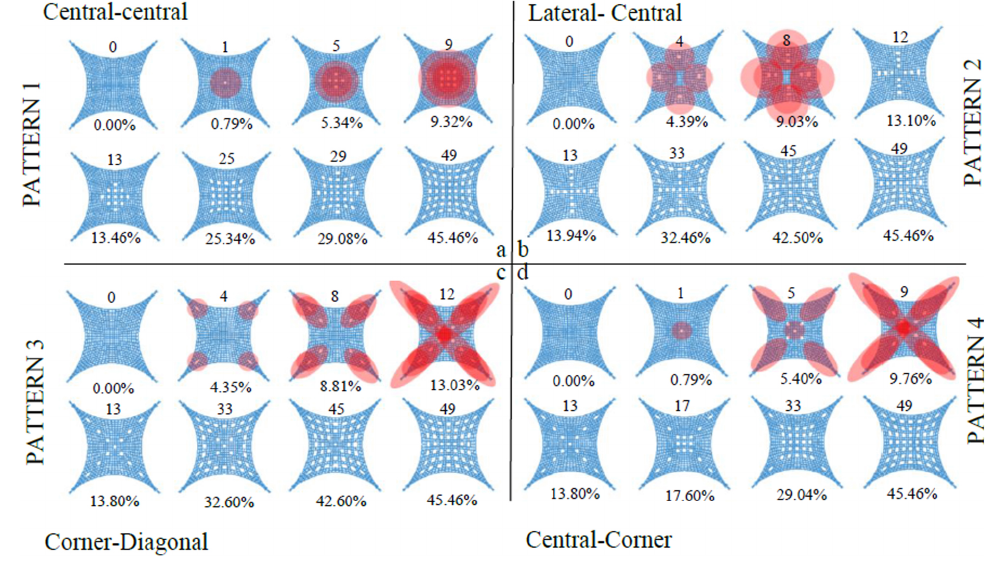
Figure 3: The different patterns were divided into 4 families according to four different strategies of the positioning of the holes. Different paths for the increasing growth of the pierced areas on the vaults are used (red shaded indicators represented the four beginning steps for the four families). For each step the percentage of the subtracted area and the number of holes are indicated near the top view of the